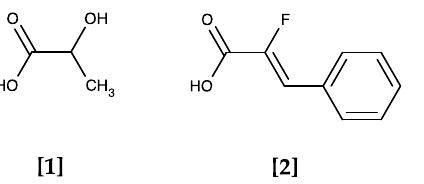
Figure 3. The PfFNT transport substrate lactic acid [1] and α -fluorocinnamic acid [2], a weak PfFNT inhibitor. Both molecules are weak monocarboxylic acids that largely deprotonate at physiological pH forming the acid anions lactate and α -fluorocinnamate.